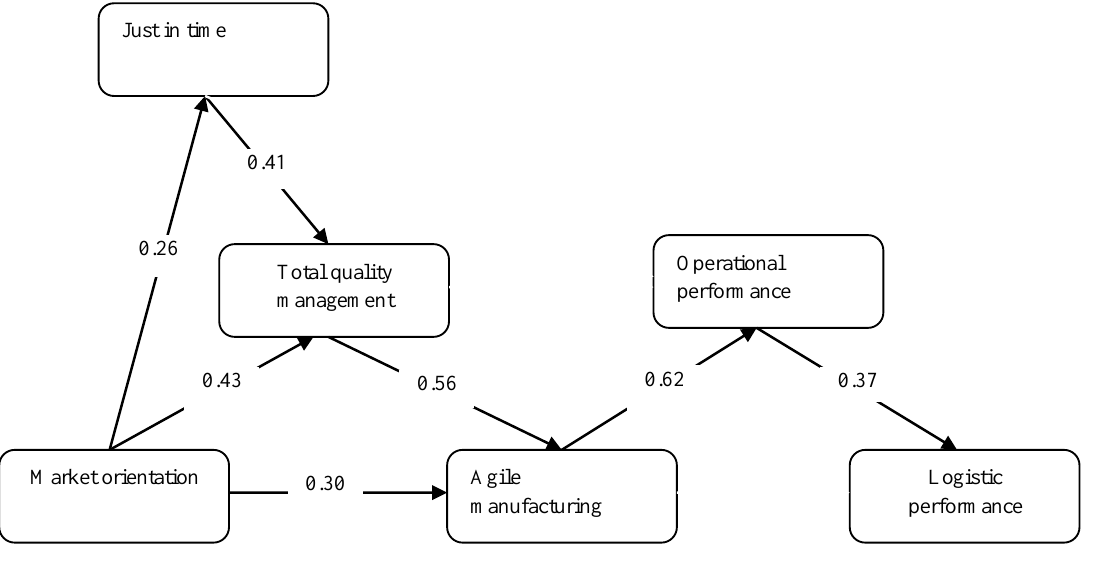
Fig 3. The revised conceptual